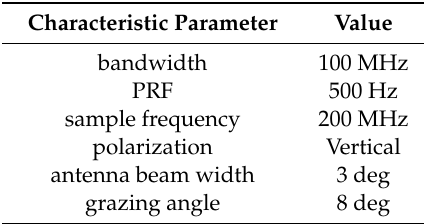
Table 1. Characteristic parameters of radar.